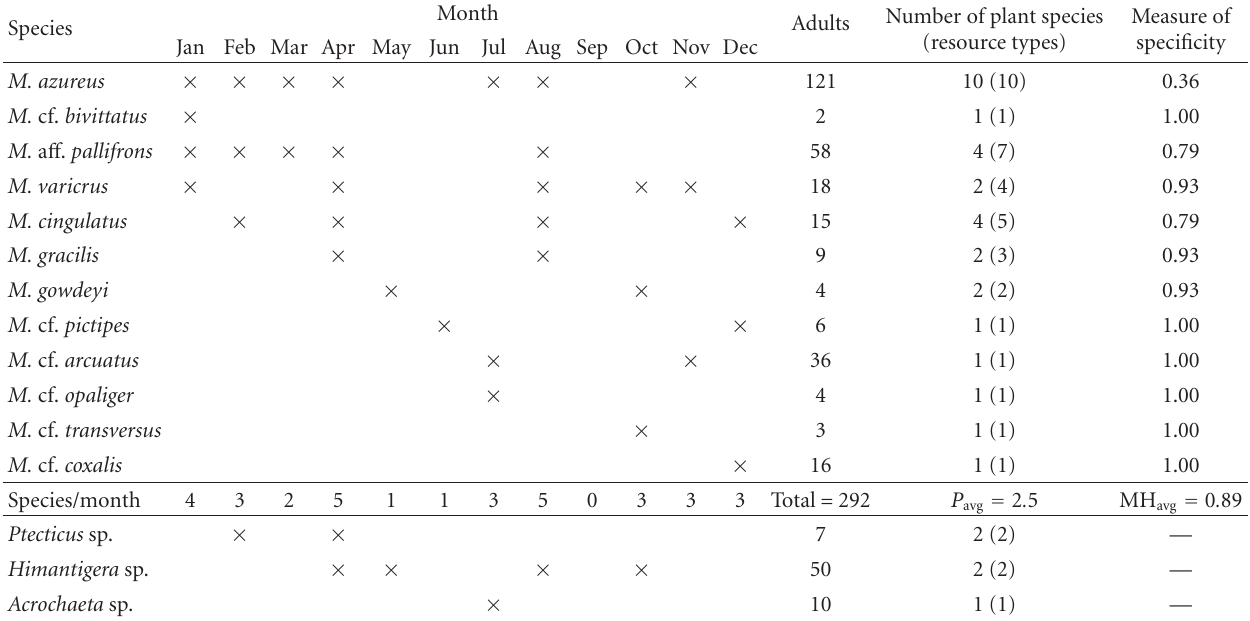
Table 3: Merosargus species, month of occurrence, number of adults reared in the laboratory, number of plant species and resources types (in brackets), and resource specificity of each species found in samples collected at the Parque Estadual do Rio Doce (PERD), Minas Gerais, Brazil, between October 2001 and October 2004.